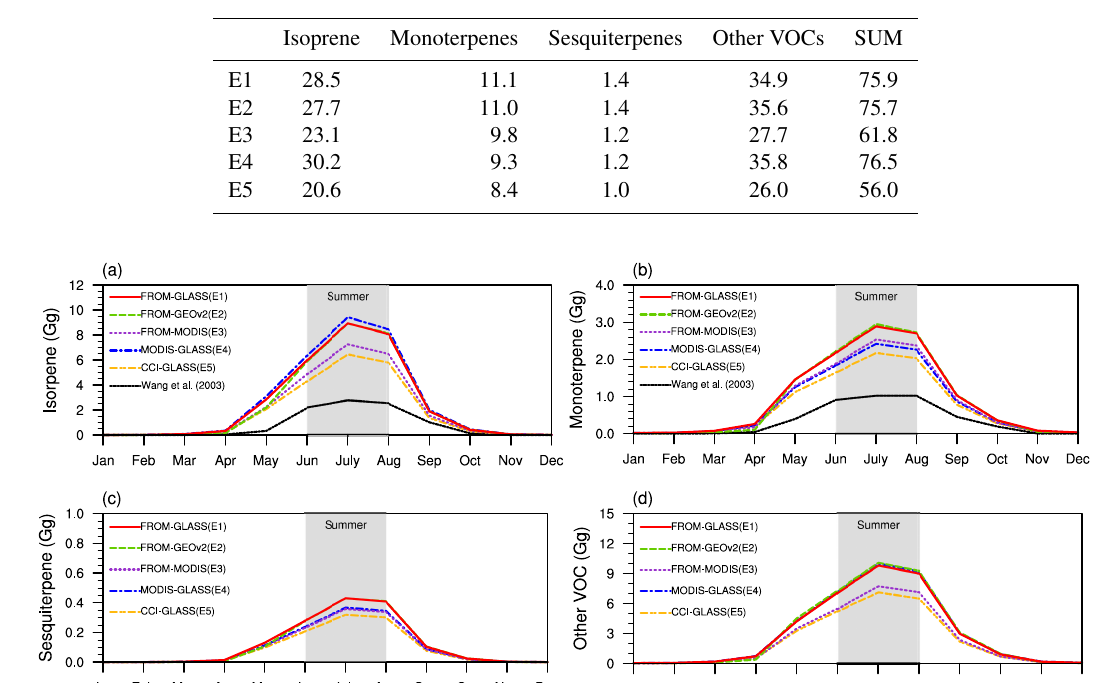
Figure 6. The temporal variability in biogenic volatile organic compounds (BVOCs) in all simulation